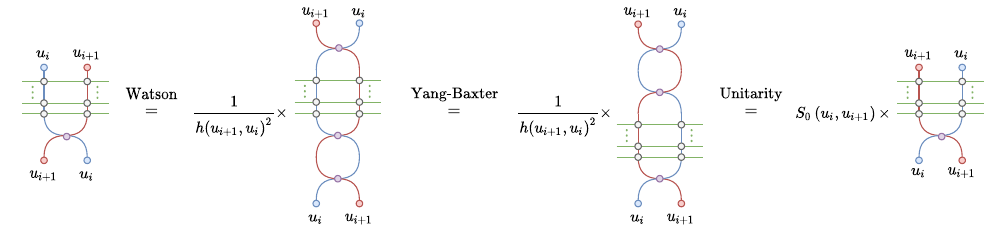
Figure 3 . The Watson axiom imply that particles in the same external set can be exchanged through the action of the SL(2 , R ) S-matrix S ( x, y ) ≡ h ( x, y ) /h ( y, x ) . This follows explicitly from 0 the fact that for identical outgoing polarizations the vertex (2.2) projects into the D element.